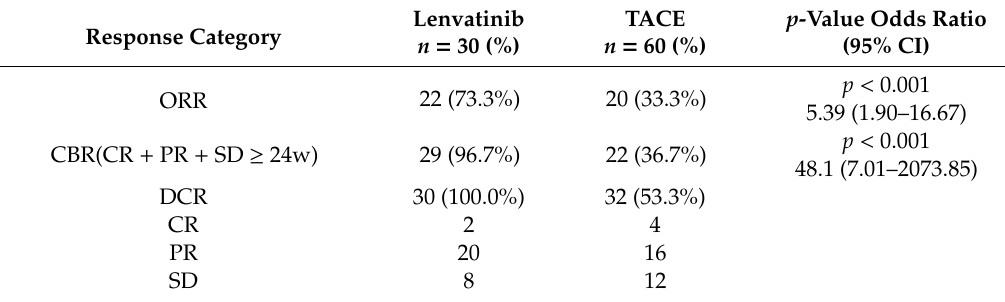
Table 2. Objective response rate (ORR) (propensity score